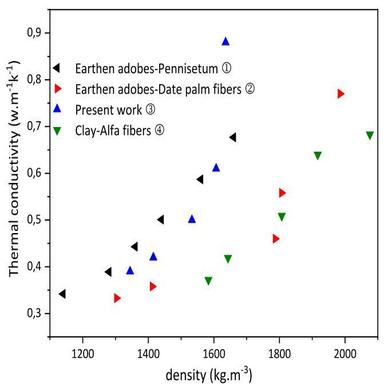
Thermal conductivity (measured vs literature): 1:; 2:; 3: Present work and 4: .